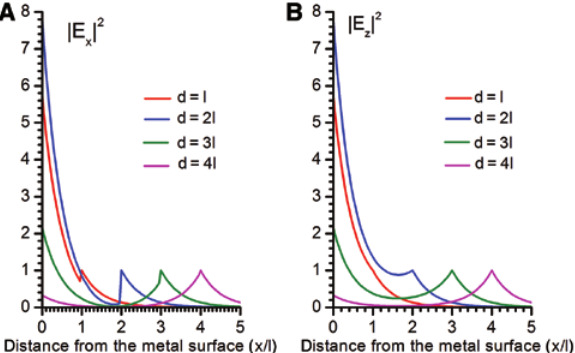
Figure 3: The transverse profile of the amplified electromagnetic mode, (A) | E | 2 and (B) | E | 2 vs the distance from the metal surface x / l x z normalized by the wavelength of the amplified mode, l = ( Re { h }) −1 . The profiles are calculated at various spacer thicknesses, d = l (red), d = 2 l (blue), d = 3 l (olive) and d = 4 l (magenta). Calculations are made at the exact resonance condition correspondent to the maximum in Figure 3B. The field amplitudes are normalized by the amplitude of the longitudinal electric field in QW